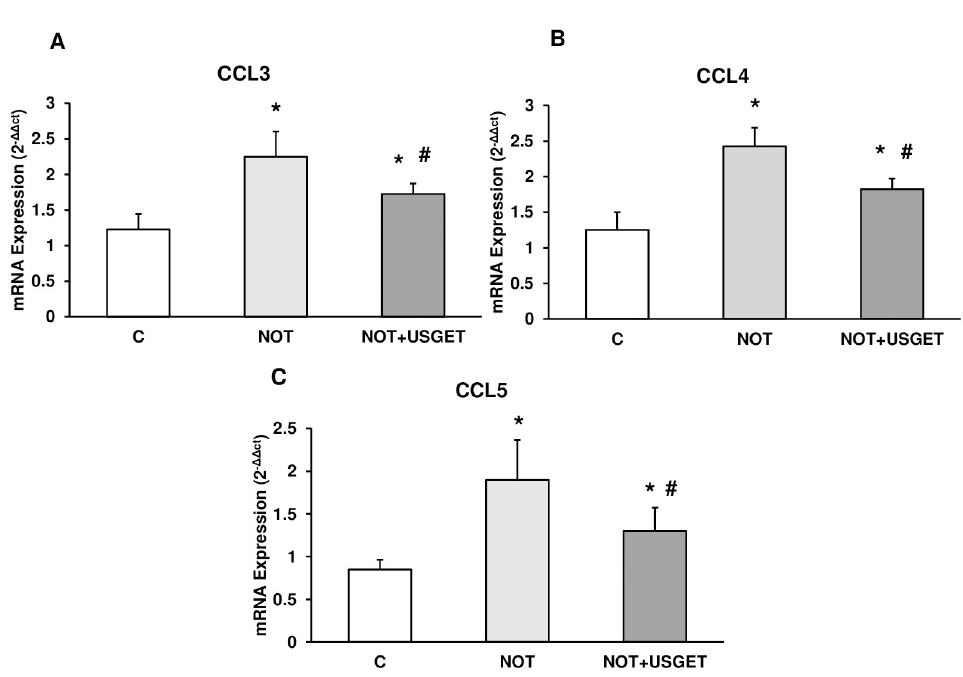
Fig 3. Rat muscle without notexin (C) or with notexin (NOT) or notexin with USGTE (6 mA) (NOT+USGTE) was collected to determine A: CCL3, B: CCL4, and C: CCL5 mRNA chemokine expression. Values are means ± SD from five independent experiments. � p < 0.05 vs. control. #p < 0.05 vs. notexin.